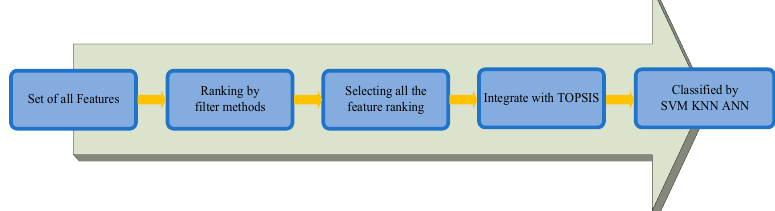
Figure 2. Schematic of the filter method proposed data analysis procedure. Table 1. Filter methods for feature selection.